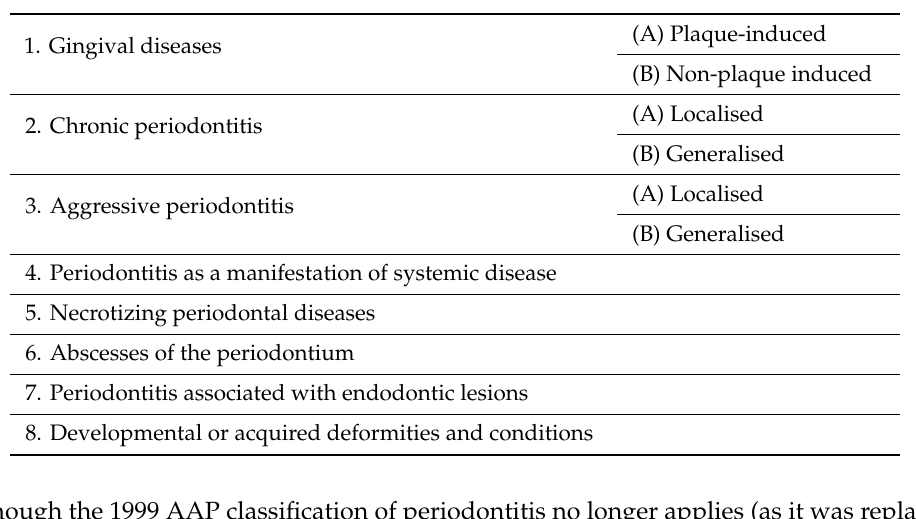
Table 4. Summary of the classification scheme AAP 1999